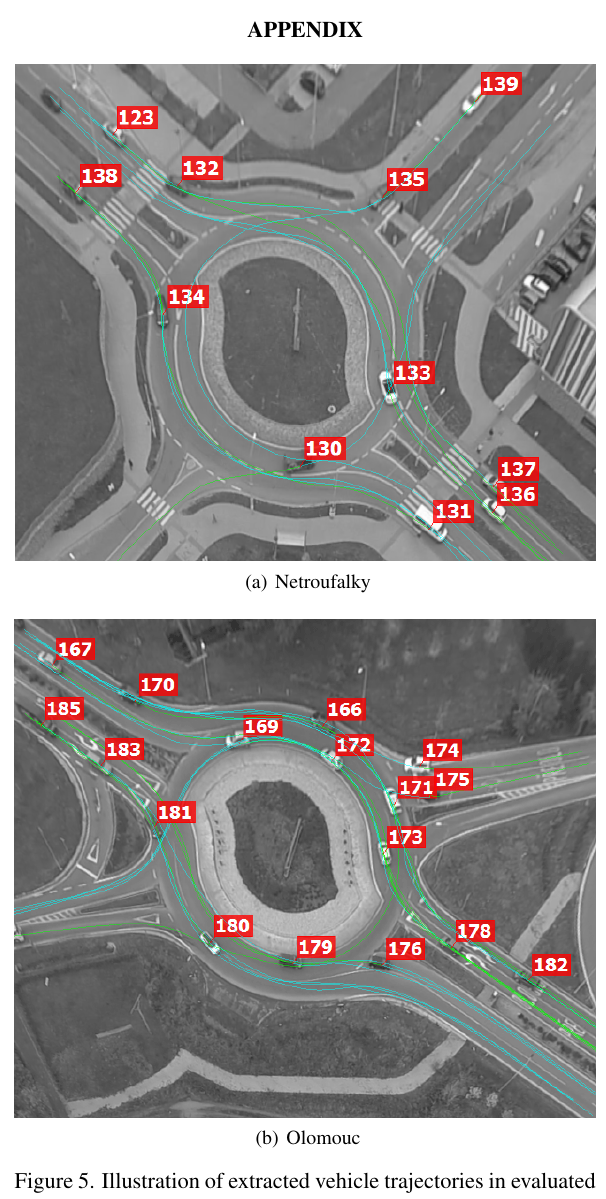
Figure 5. Illustration of extracted vehicle trajectories in evaluated traffic scenes. The images are converted to grayscale for bet- ter readability of overlay graphics: blue-green curves represent vehicle trajectories and red labels with white numbers represent unique identificators of tracked objects.